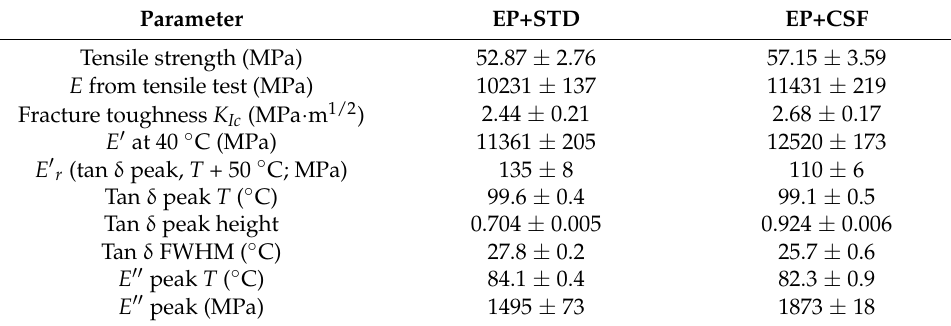
Table 4. Mechanical parameters measured for the reference sample and the composite filled with Al 2 O 3 @AlN core-shell